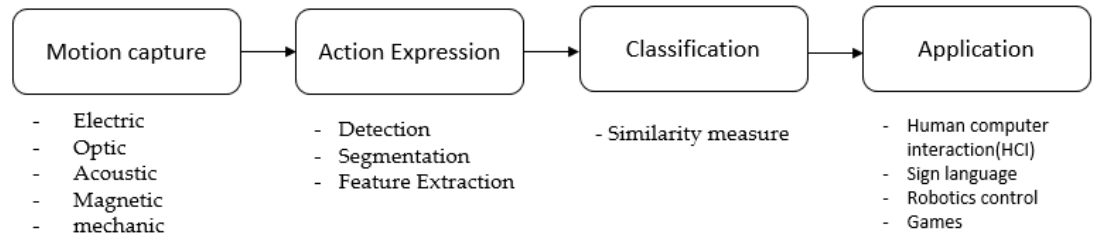
Figure 1. A flow of motion recognition system.